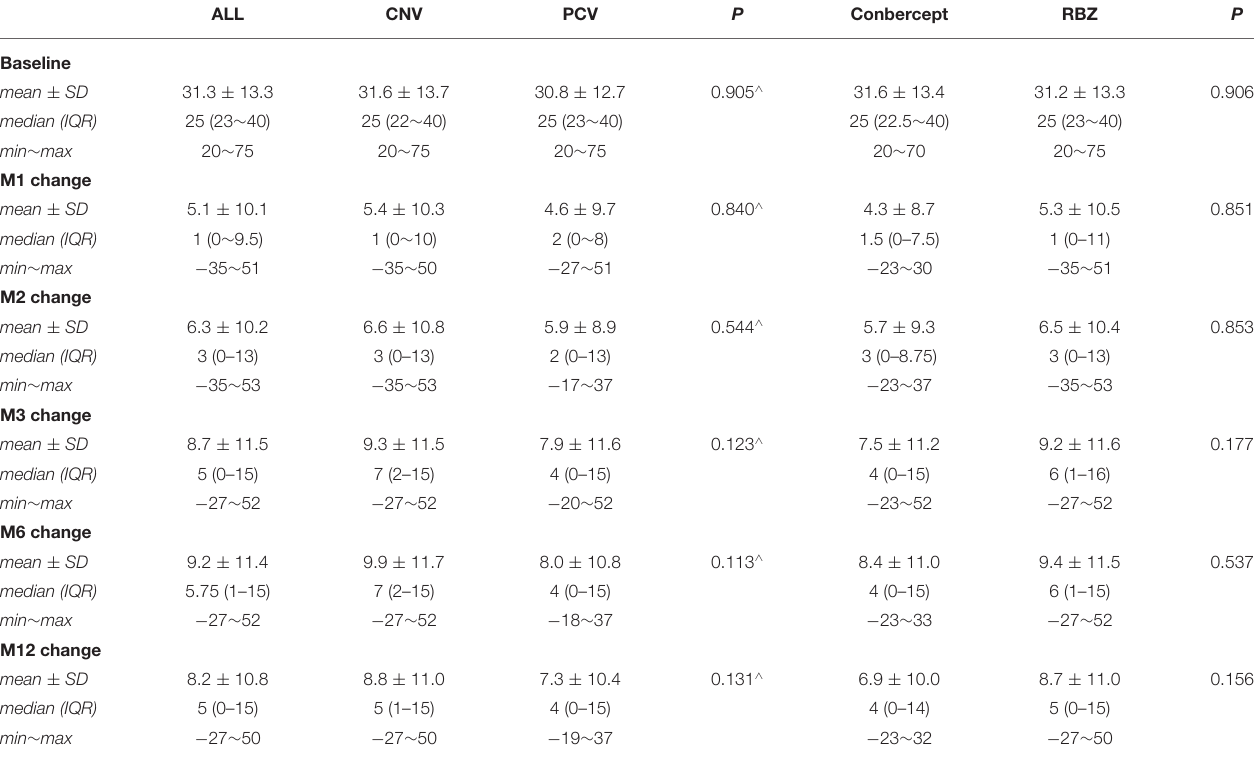
TABLE 3 | Mean BCVA changes compared with baseline (ETDRS letters). ALL CNV PCV P Conbercept RBZ